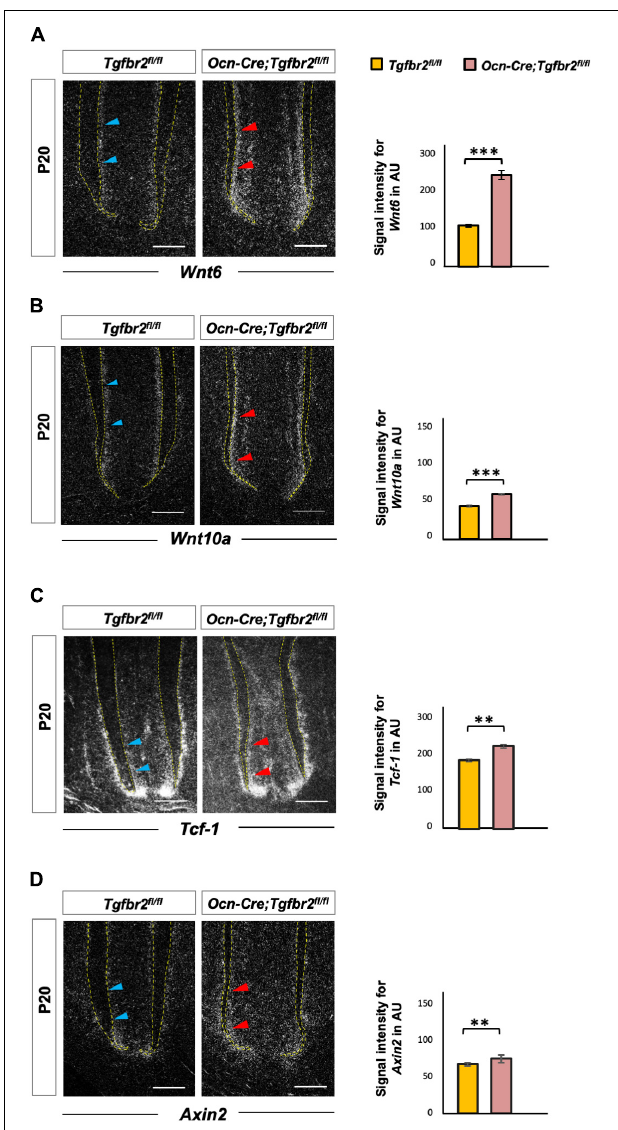
FIGURE 3 | Increased Wnt signaling in the root pre-odontoblasts of Ocn-Cre ; Tgfbr2 fl / fl mice. (A,B) Elevated expression of Wnt ligands, Wnt6 and Wnt10a , in root odontoblasts of the Ocn-Cre ; Tgfbr2 fl / fl mice at P20 as indicated by red arrowheads. (C,D) Increased expression of Wnt signaling read-out genes in the root odontoblasts of Ocn-Cre ; Tgfbr2 fl / fl mice compared to the Tgfbr2 fl / fl littermates as indicated by red arrowheads at P20. N = 4 mice/per genotype in (A–D) . The right images of bar graphs are quantification of signal intensity for Wnt6 , Wnt10a , Tcf-1 , and Axin2 expression as shown in (A–D) using ImageJ. Data are presented as the means ± standard deviation (SD). *** P < 0.001, ** P < 0.01, n = 4 areas from three mice. Blue arrowheads in (A–D) indicate expression of Wnt ligands and related genes in Tgfbr2 fl / fl mice. Scale bars: 50 µ